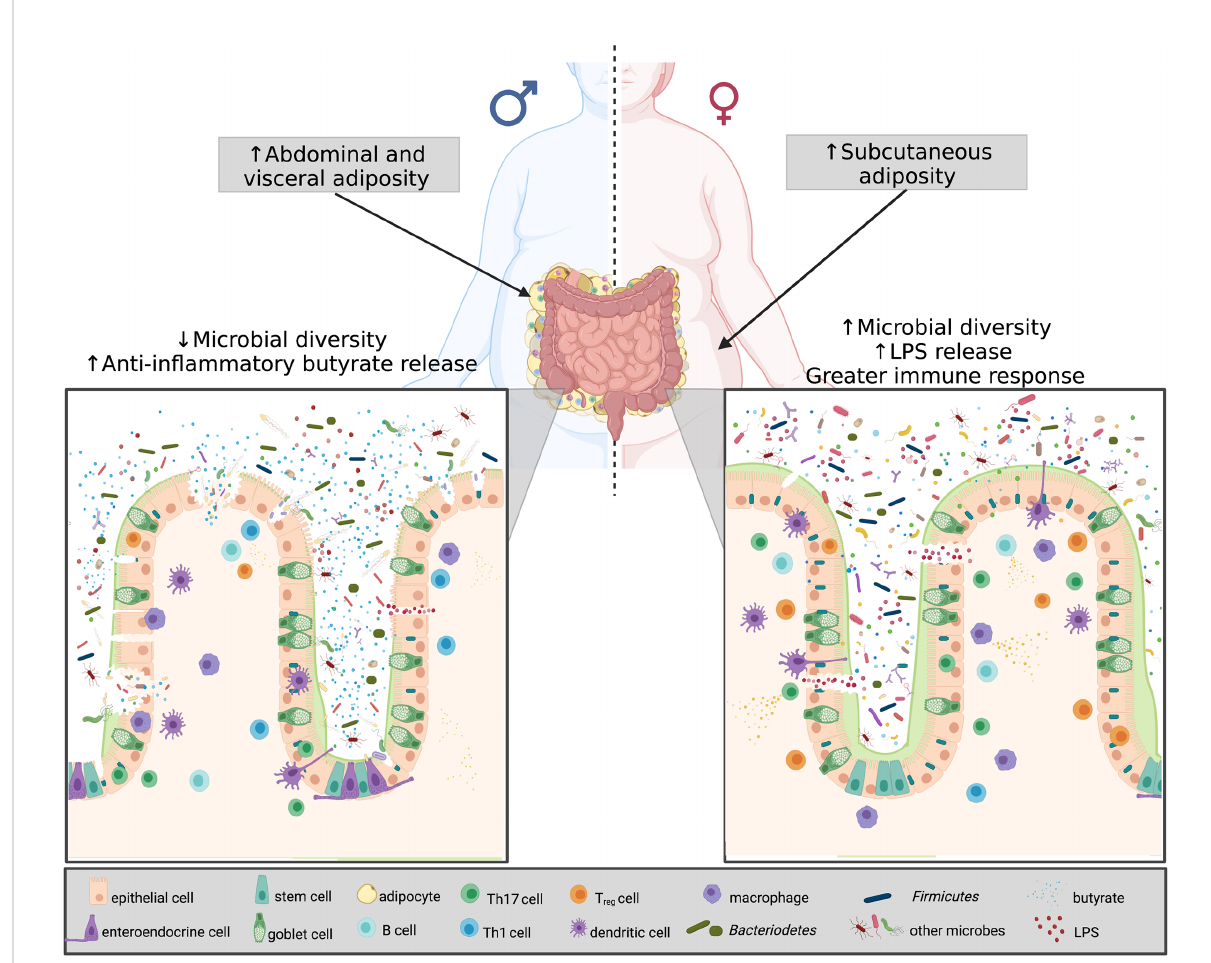
FIGURE 3 Microbial diversity, sex hormones and chromosomes in obesity. Differences in sex-based characteristics are modulated by a variety of factors. Women have a greater degree of subcutaneous fat, whereas males predominantly accumulate visceral fat. In obesity, the shift in the Firmicutes: Bacteroidetes determines disease severity. Obese males have less species richness, and testosterone was found to be associated with increased Firmicutes, thus more anti-in fl ammatory butyrate release. Obese females, on the other hand, despite having greater microbial diversity, have an increase estradiol and Bacteroidetes, resulting in greater LPS release, thus eliciting a greater immune response. Created with